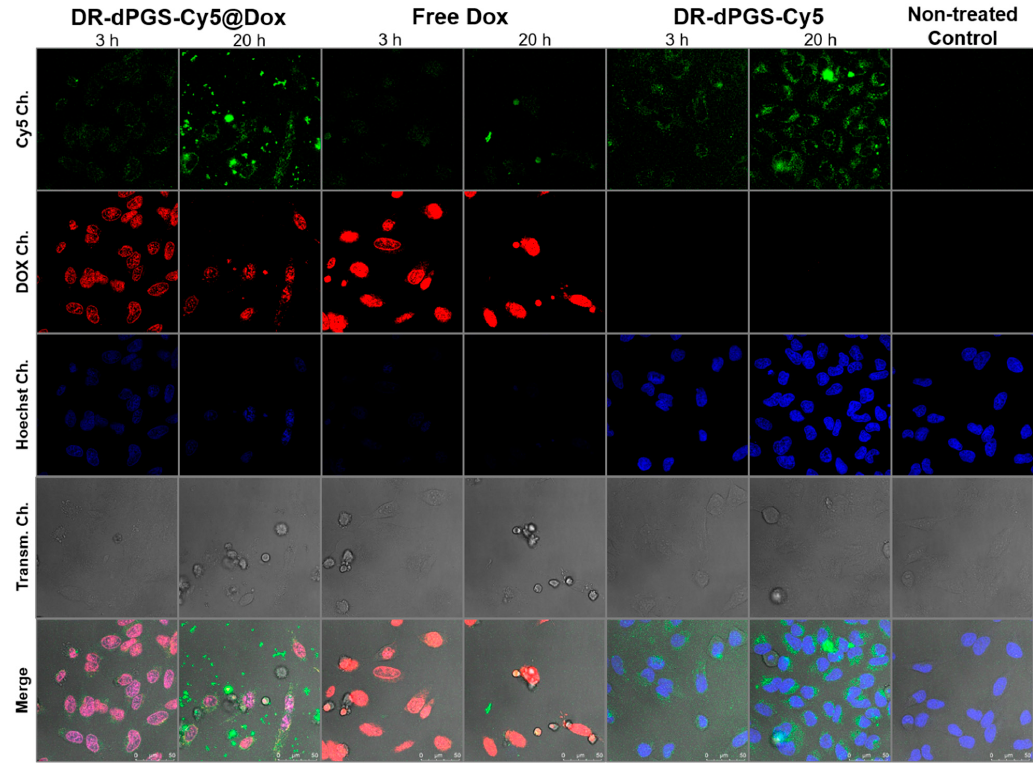
Figure 5. Confocal Microscope images of HeLa cells treated with DR-dPGS-Cy5 with and without DOX, free DOX for 3 h and 20 h, respectively, and nontreated cells. Blue: Hoechst (nuclei); red: DOX, green: Cy5-labelled carrier. Scale bar indicates 50 µm.